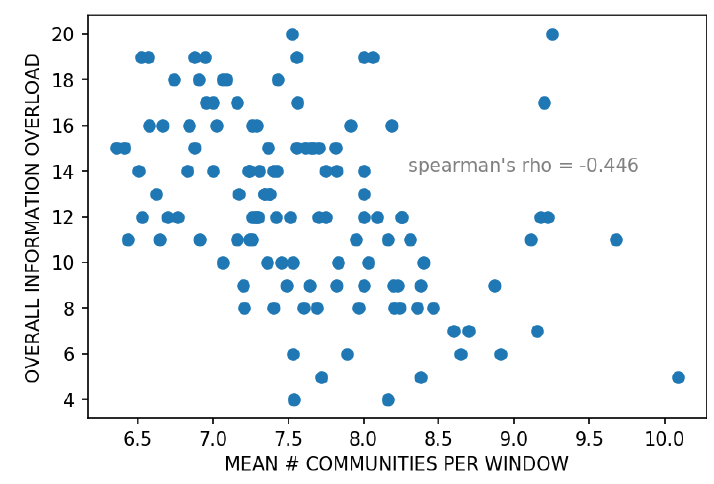
Figure 6. Number of Communities vs. Information Overload Score.